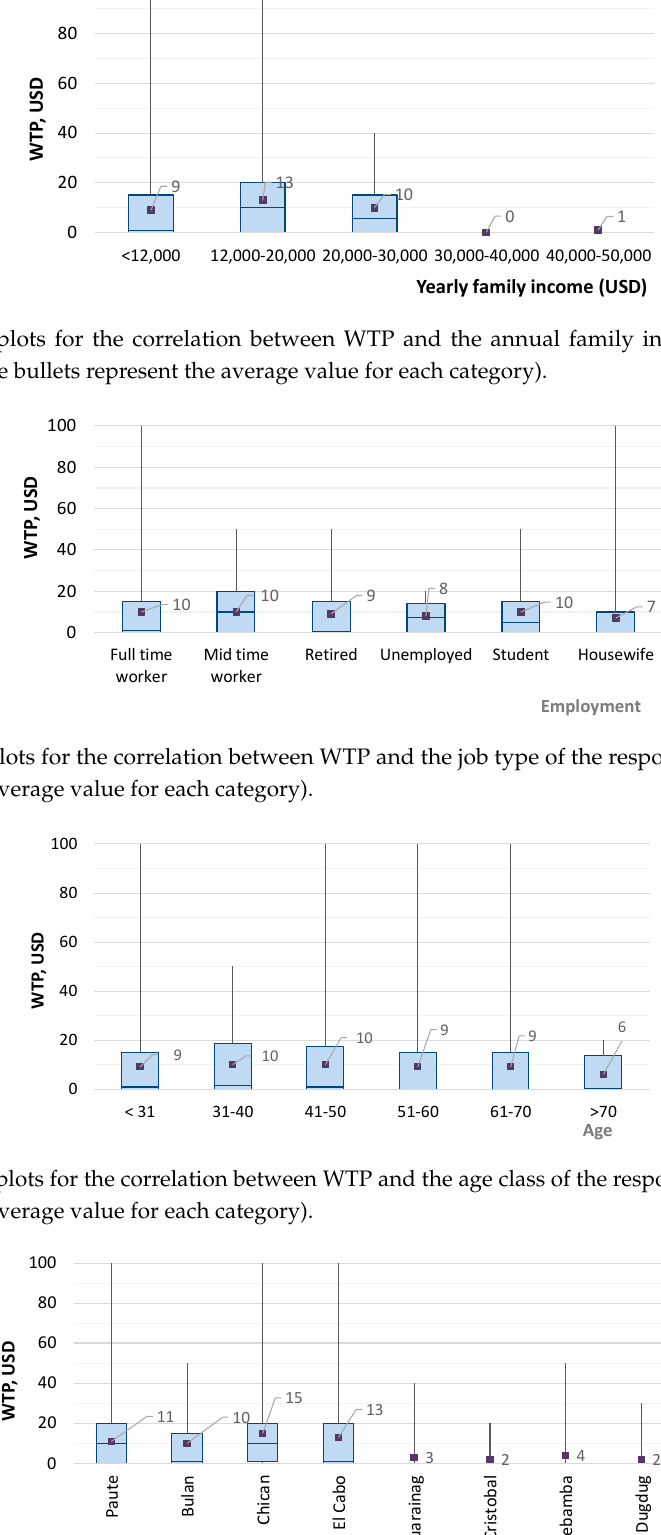
Figure 7. Box-plots for the correlation between WTP and education level of the respondents (the bullet represents the average value for each category).